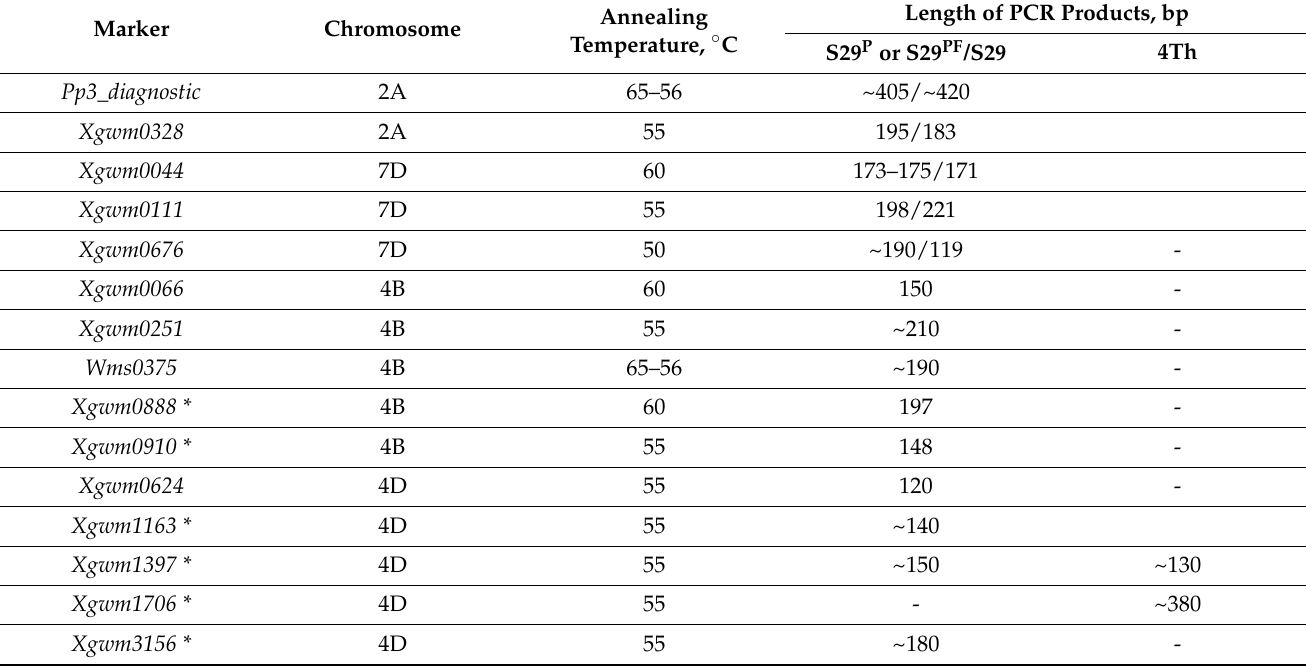
Table 1. Molecular markers used for DNA analysis of the bread wheat lines.